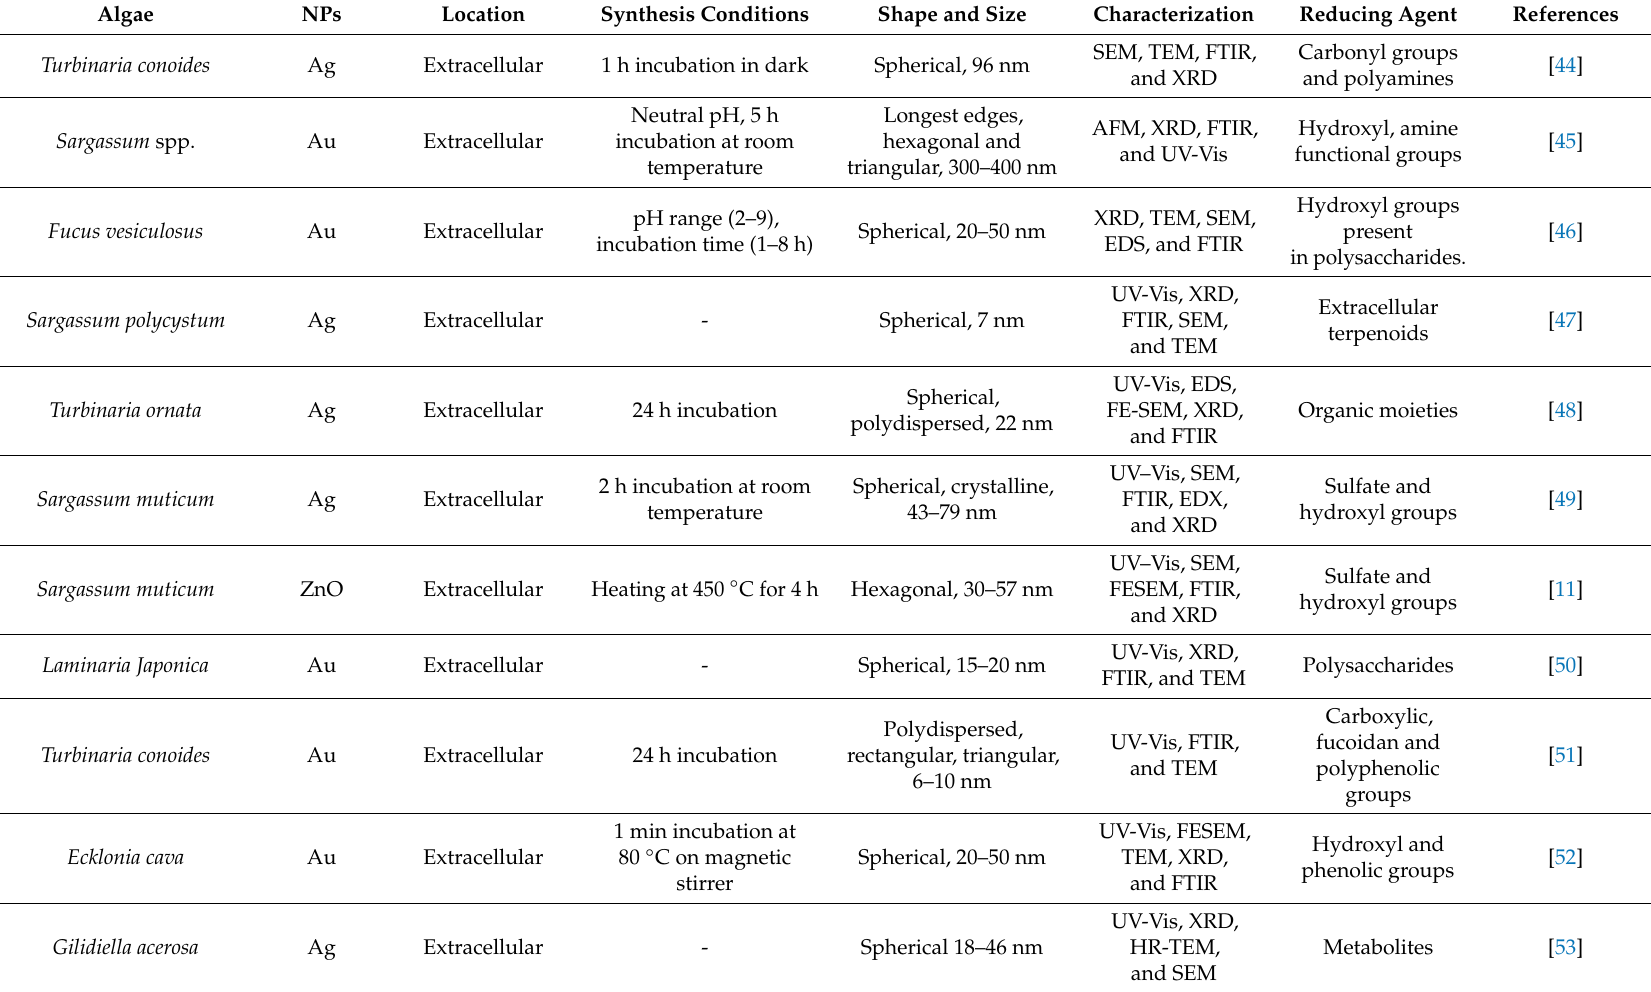
Table 1. Brown algae-mediated biosynthesis of metallic